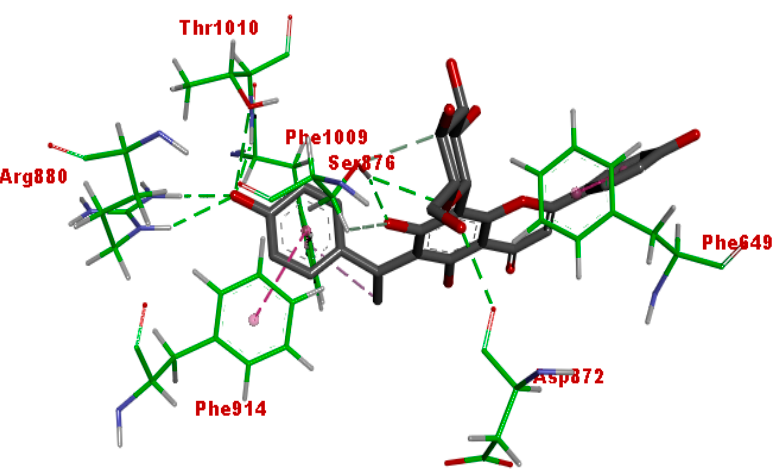
Figure 10. Binding interaction of cucumerin A with the active site of xanthine oxidase (PDB code: 3NVY). Green and purple dashes represent hydrogen-bonding and hydrophobic interactions, respectively.